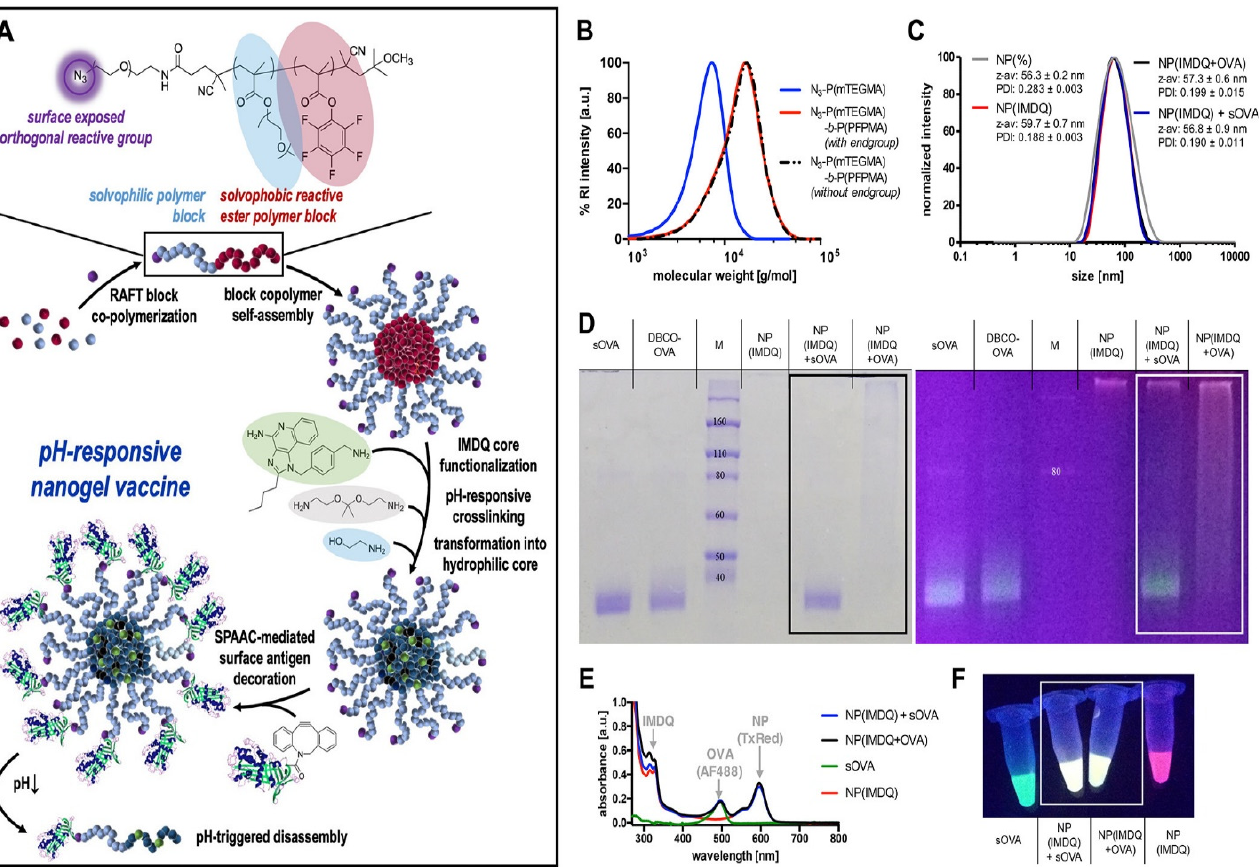
Figure 4. Characterization of TLR7/8-agonist- and protein-conjugated NGs for precise co-delivery of adjuvant and antigen during intravenous antitumor vaccination. ( A ) Synthetic design concept based on double reactive precursor block copolymers that self-assemble into block copolymer micelles with amine-reactive cores and a SPAAC-reactive corona. Using aminolysis of the pentafluorophenyl esters, the cores are covalently functionalized with the TLR 7/8 agonist IMDQ and Texas Red, and then sequentially cross-linked and transformed into pH-responsive NGs. The corona is modified via click ligation of the surface-exposed azides to DBCO-modified (and Alexa Fluor 488-labeled) OVA as a model antigen. ( B ) Size exclusion chromatography of the RAFT-derived reactive homo and block copolymer (before and after removal of the dithiobenzoate end group). ( C ) Dynamic light scattering intensity size distribution plots of the resulting NGs (with and without covalent IMDQ loading), mixed or covalently modified with OVA. ( D ) SDS-PAGE of modified OVA (labeled with Alexa Fluor 488) mixed or covalently conjugated to IMDQ-loaded NGs (labeled with Texas Red) (left, Coomassie staining; right, UV excitation of the fluorescent dyes (red, Texas Red-labeled NG; green, Alex Fluor 488-labeled OVA)). ( E ) UV–vis spectrum of the fluorescently labeled samples and ( F ) corresponding image of the samples upon excitation by a UV lamp. Reproduced from Stickdorn et al. [143] with permission from American Chemical Society, USA.